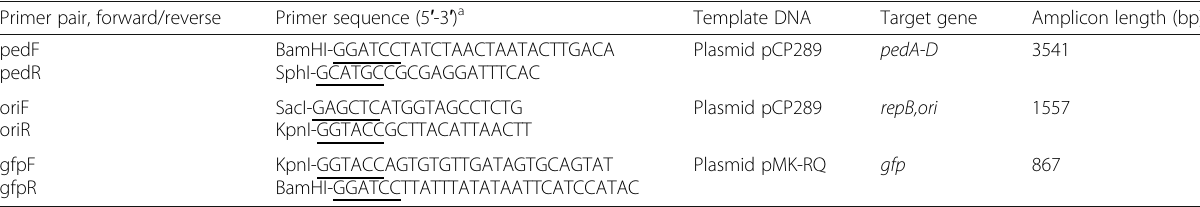
Table 2 List of PCR primer pairs used for amplification Primer pair,